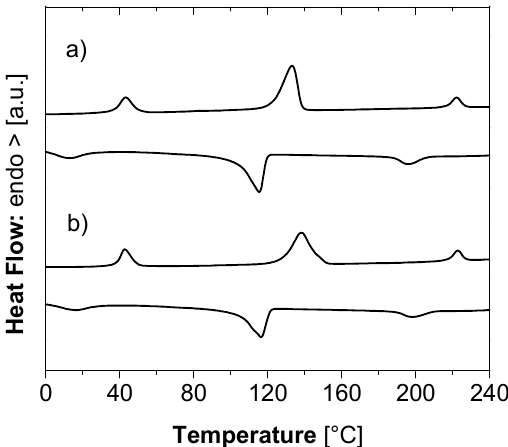
Figure 4. Differential scanning calorimetry (DSC): thermograms recorded during heating and cooling of ribbons of UHMWPE–[Fe(NH 2 trz) 3 ](2ns) 2 blends comprising 33.3% m / m [Fe(NH 2 trz) 3 ](2ns) 2 . The ribbons were prepared by gel-processing with stearic acid as a solvent followed by extraction of stearic acid with diethyl ether. ( a ) undrawn, ( b ) drawn to a draw ratio of 10. Table 1. Peak temperatures observed in DSC thermograms (heating/cooling cycles) of UHMWPE– [Fe(NH 2 trz 3 )](2ns) 2 blends comprising 33.3% m / m [Fe(NH 2 trz) 3 ](2ns) 2 represented in Figure 4, in the undrawn state ( λ = 1) and after drawing to a draw ratio λ of 10. T SCO denominates the spin crossover temperature of [Fe(NH 2 trz) 3 ](2ns) 2 , T m the melting temperature of UHMWPE and T high a characteristic high-temperature transition of [Fe(NH 2 trz) 3 ](2ns) 2 . λ [–]